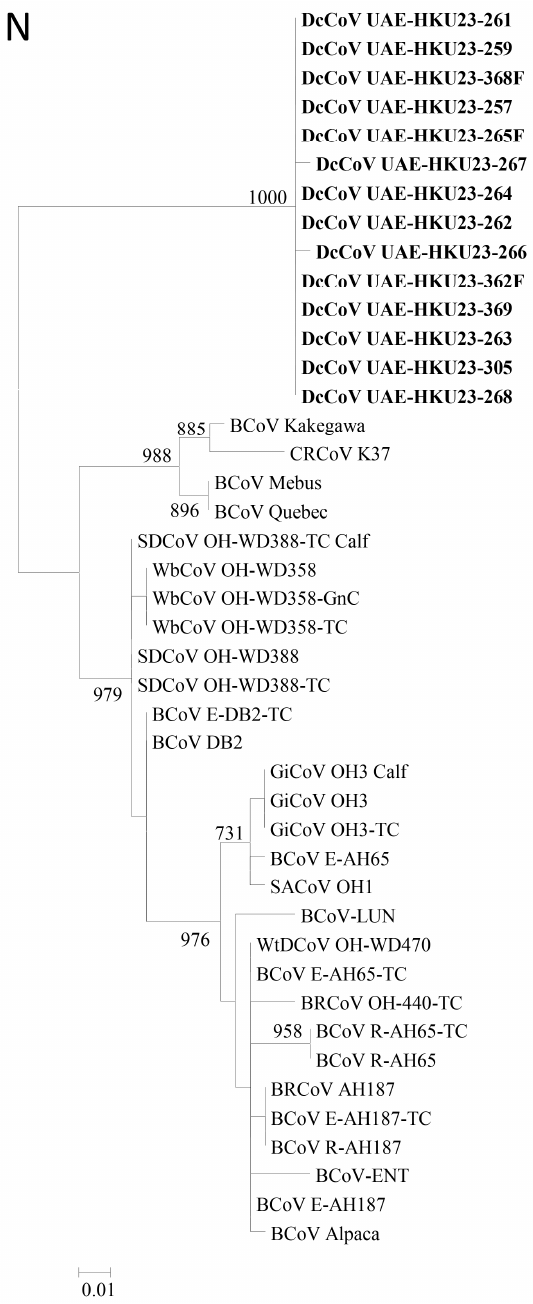
Figure 5. Phylogenetic analyses of RNA-dependent RNA polymerase (RdRp), S, and N genes of dromedary camel coronavirus (DcCoV) UAE-HKU23. Included in the analysis were 2784, 4101, and 1347 nucleotide positions in RdRp, S and N, respectively. For RdRp, the scale bar indicates the estimated number of substitutions per 200 nucleotides. For S, the scale bars indicate the estimated number of substitutions per 50 nucleotides. For N, the scale bars indicate the estimated number of substitutions per 100 nucleotides. Bootstrap values were calculated from 1000 trees and those below 70% are not shown. The 14 strains of DcCoV UAE-HKU23 characterized in this and our previous studies are shown in bold. BCoV, bovine coronavirus; CRCoV, canine respiratory coronavirus; SDCoV, sambar deer coronavirus; WbCoV, waterbuck coronavirus; WtDCoV, white-tailed deer coronavirus; BRCoV, bovine respiratory coronavirus; GiCoV, giraffe coronavirus; SACoV, sable antelope coronavirus.